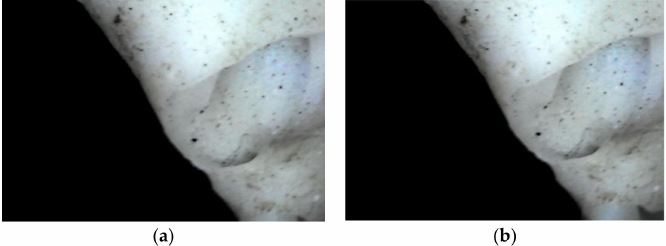
Figure 16. Microscopic morphology of Stone—liquid silica gel interface ( a ) Smooth interface; ( b ) Magnified morphology of smooth